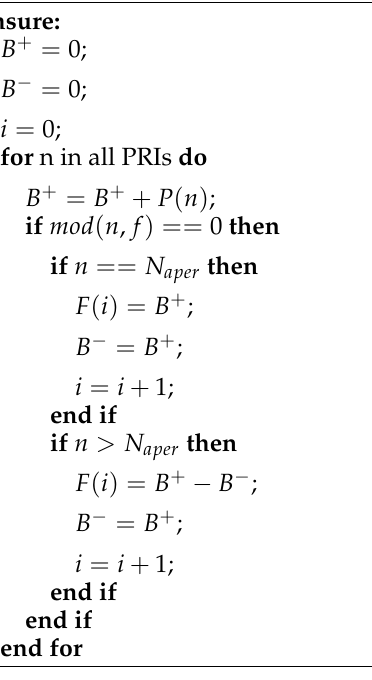
Algorithm 1 Video-SAR back-projection algorithm.